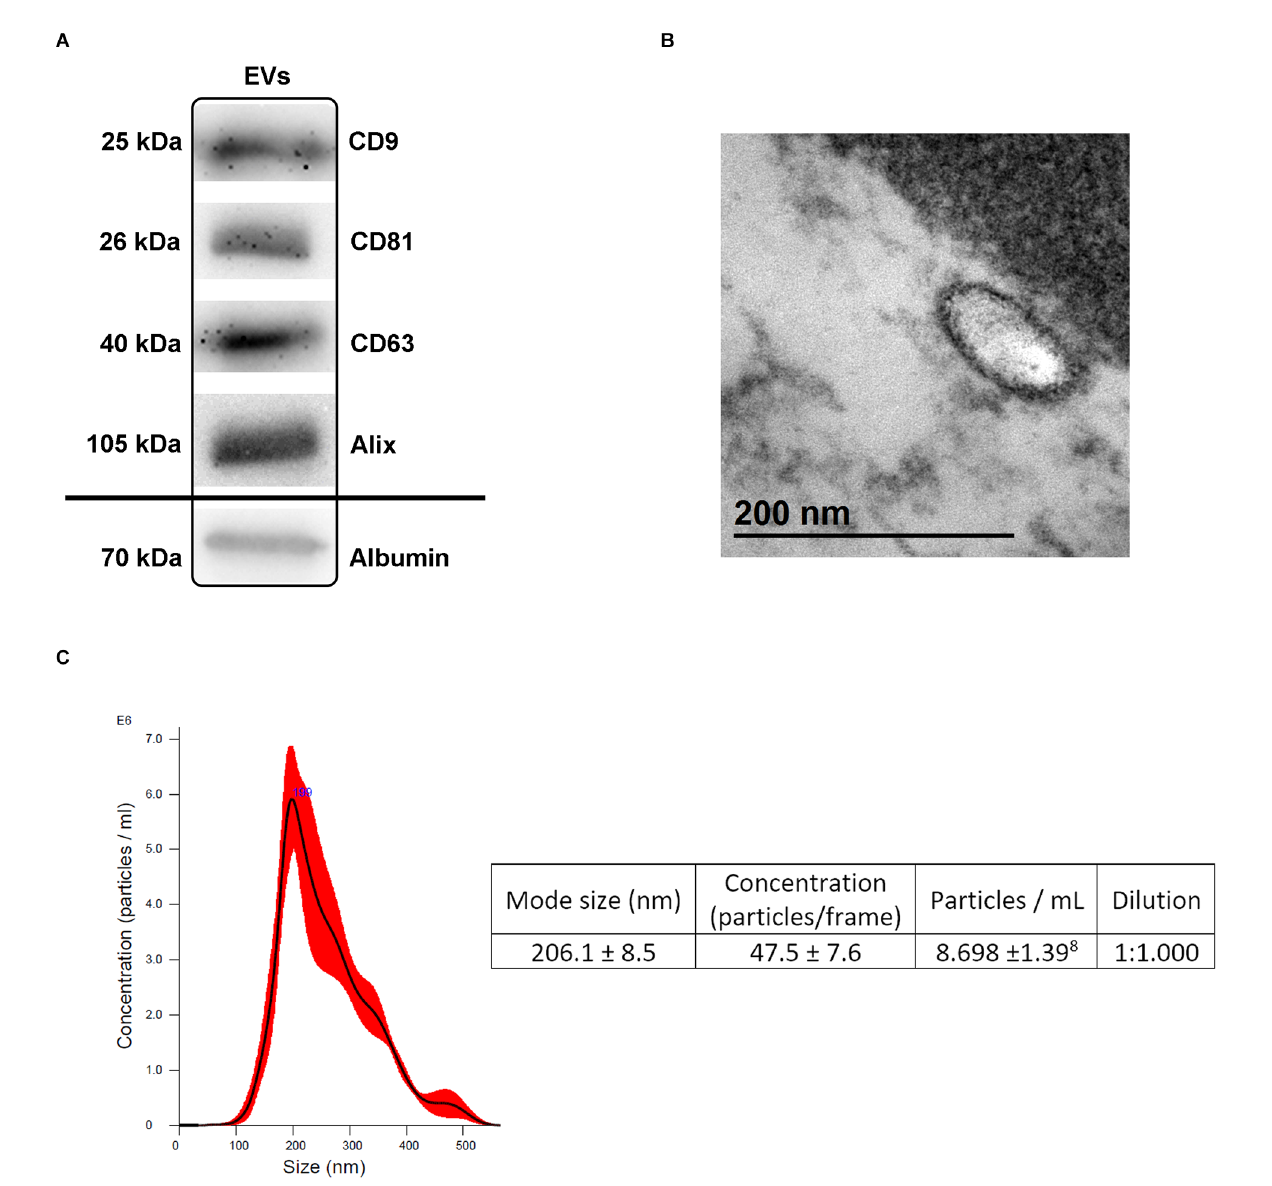
FIGURE2 Extracellular vesicles (EVs) characterization. (A) Presence of specific EVs proteins (CD9, CD81, CD63, Alix) and albumin as a purity control by Western blot analysis following isolation. (B) Transmission electron microscopy (TEM) images illustrating the characteristic size and form of the EVs. (C) NTA illustrating the size and concentration of the EVs. Abbreviations: EVs, extracellular vesicles; NTA, nanoparticle tracking